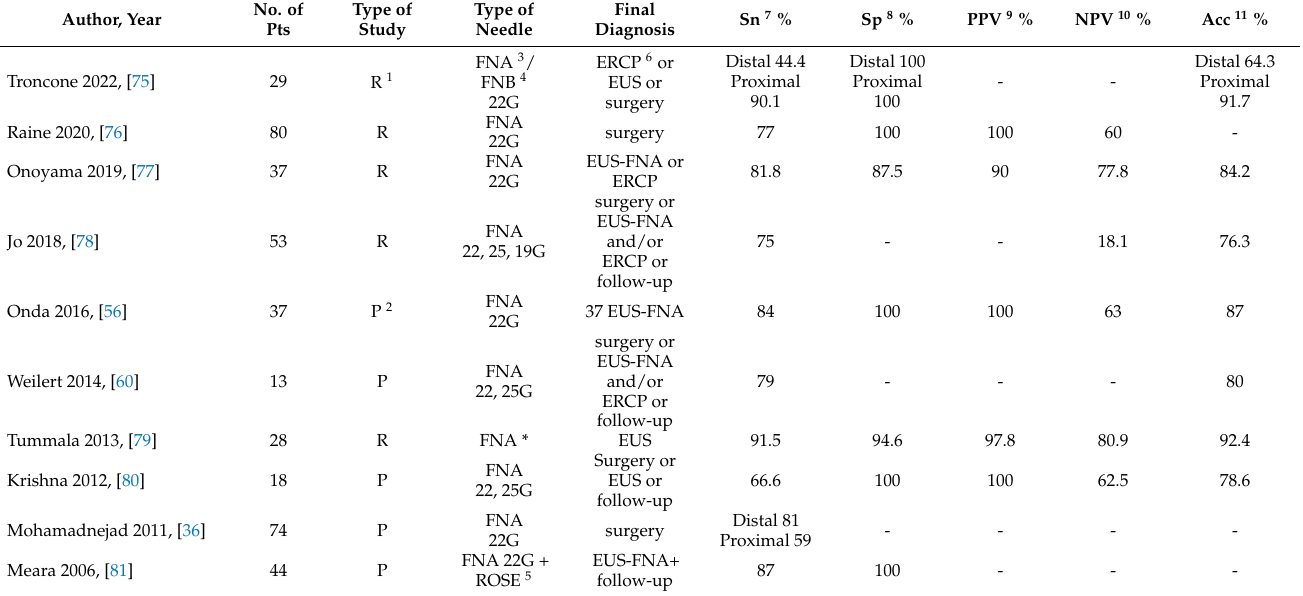
Table 3. The diagnostic value of endoscopic ultrasound tissue acquisition in